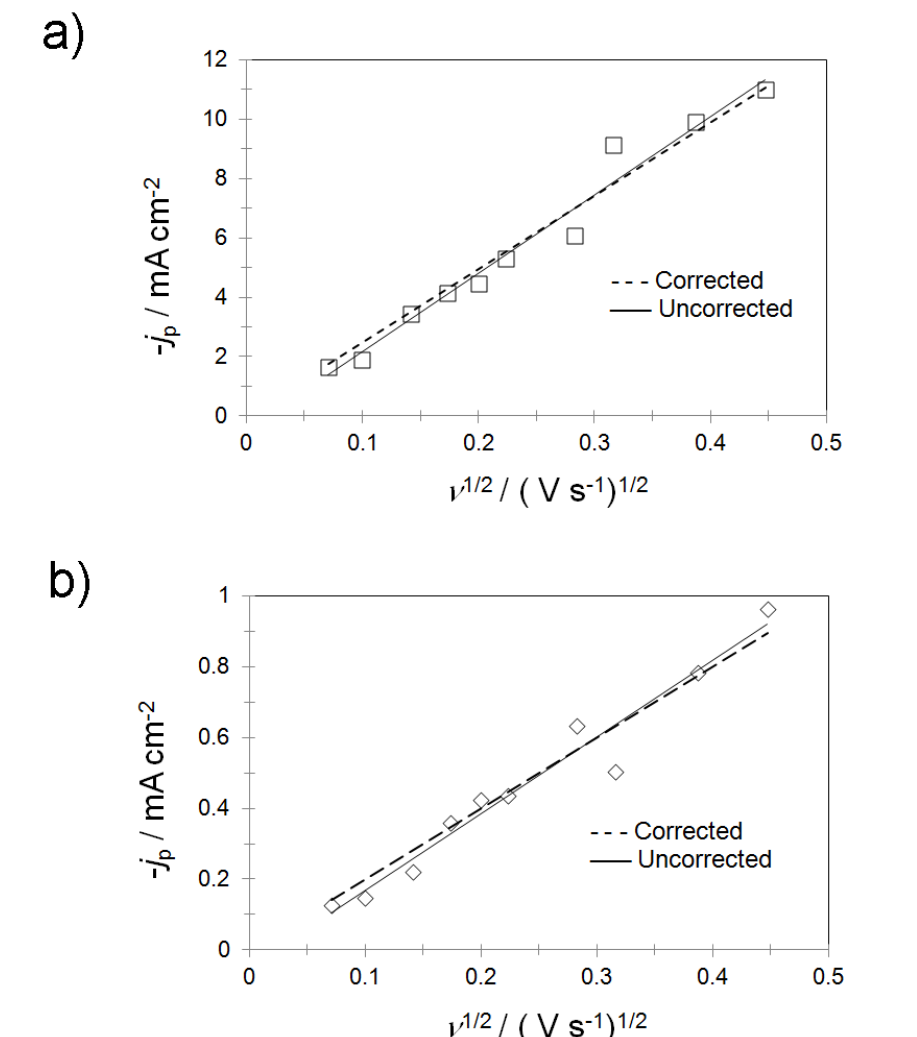
Figure 5. Plot of the experimental cathodic density peak current (j ) as a function of the scan rate ( ν ½ ) for a) peak A and b) peak B (see Fig. 1). p The solid line represents an uncorrected linear fit. The broken line corresponds to the corrected linear fit according to [